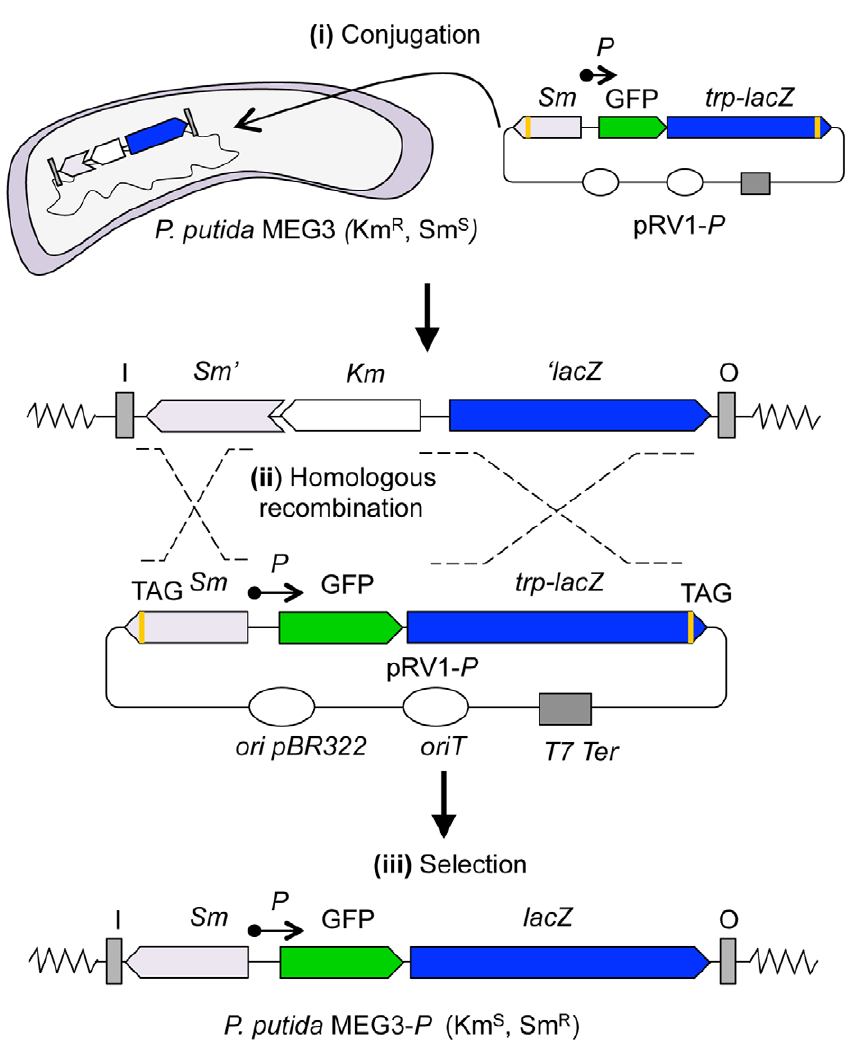
Figure 4. Design of bicistronic GFP- lacZ reporter strains. (i) pRV1 containing the cloned promoters (labeled as P ) was introduced into the P. putida MEG3 strain by conjugation. Colonies were selected in minimal media using the Sm antibiotic. (ii) The homology regions of the suicide vector pRV1 were recombined with the two segments placed in the chromosome, generating a functioning Sm/Sp resistance marker and lacZ gene. (iii) Finally, the correct insertion of the segments generated a strain with a stable reporter system that was sensitive to the Km antibiotic.